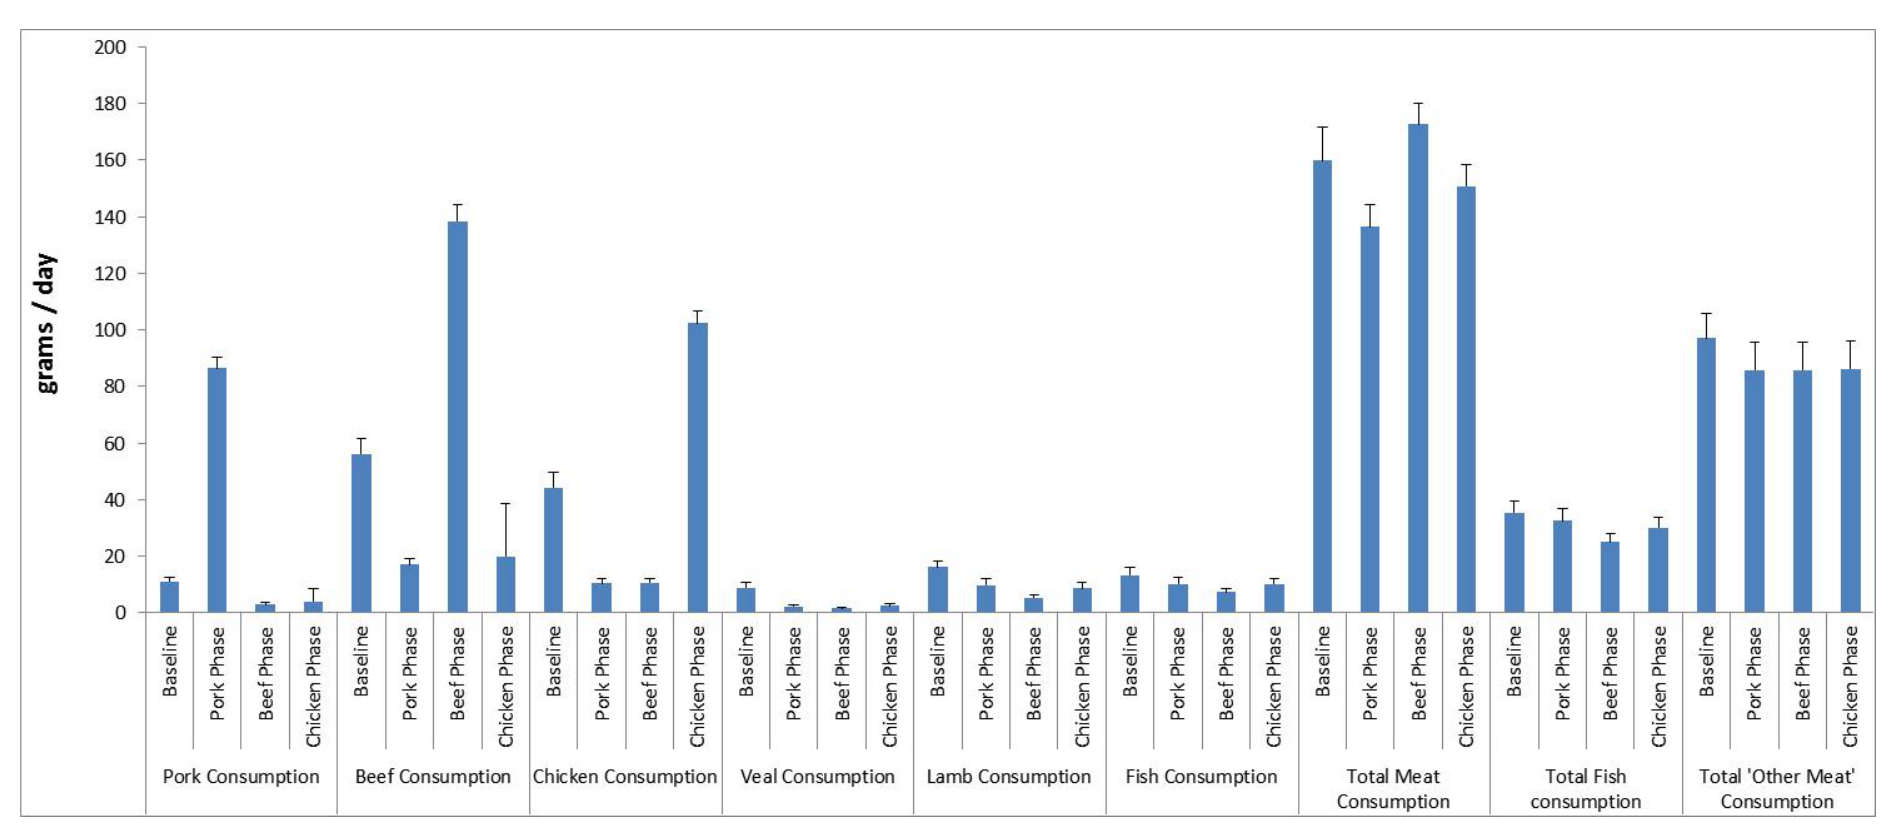
Figure 2. Average meat and fish consumption (grams per day ± SEM) from the Cancer Council of Victoria Food Frequency Questionnaire at baseline and for each dietary phase (beef, pork, chicken) n =